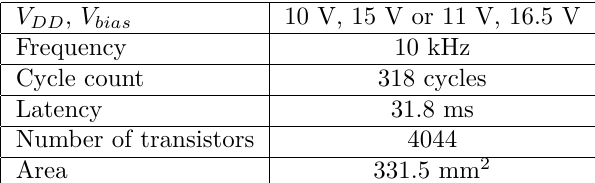
Table 1: Settings and implementation results for the KTANTAN32